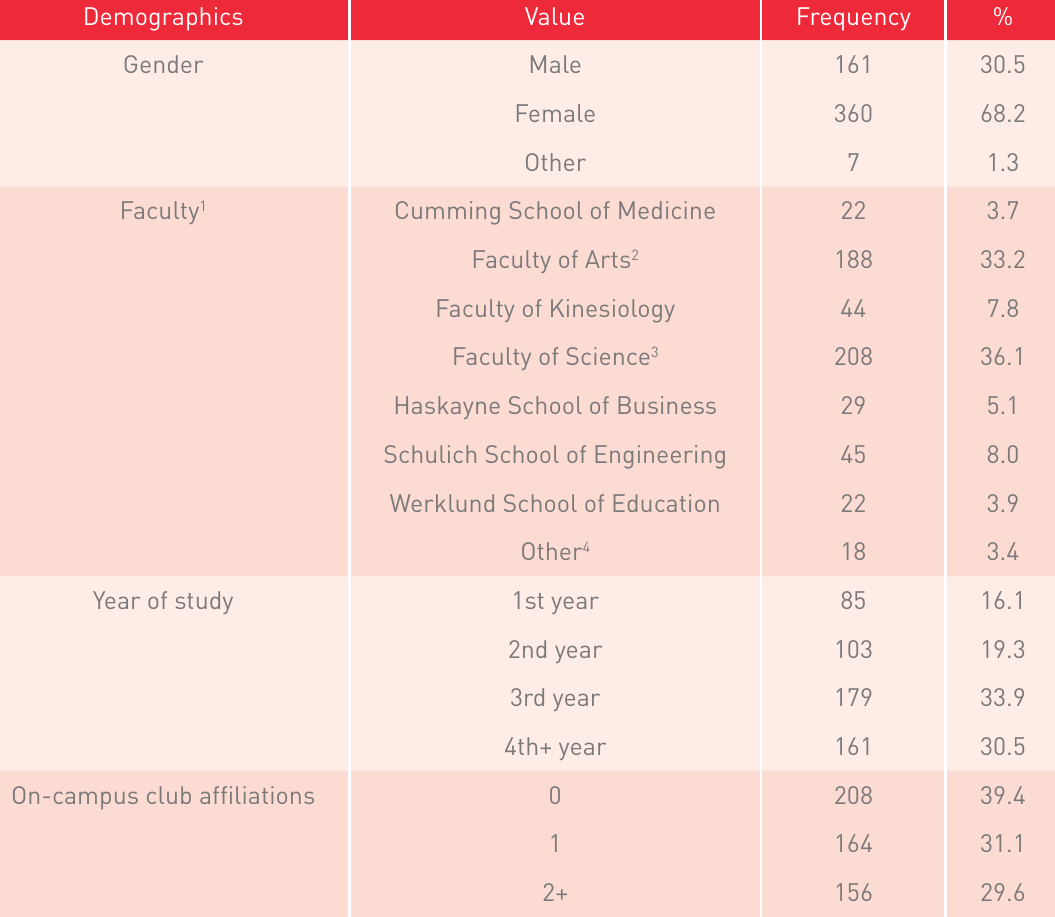
Demographic profile distribution of survey respondents ( n =